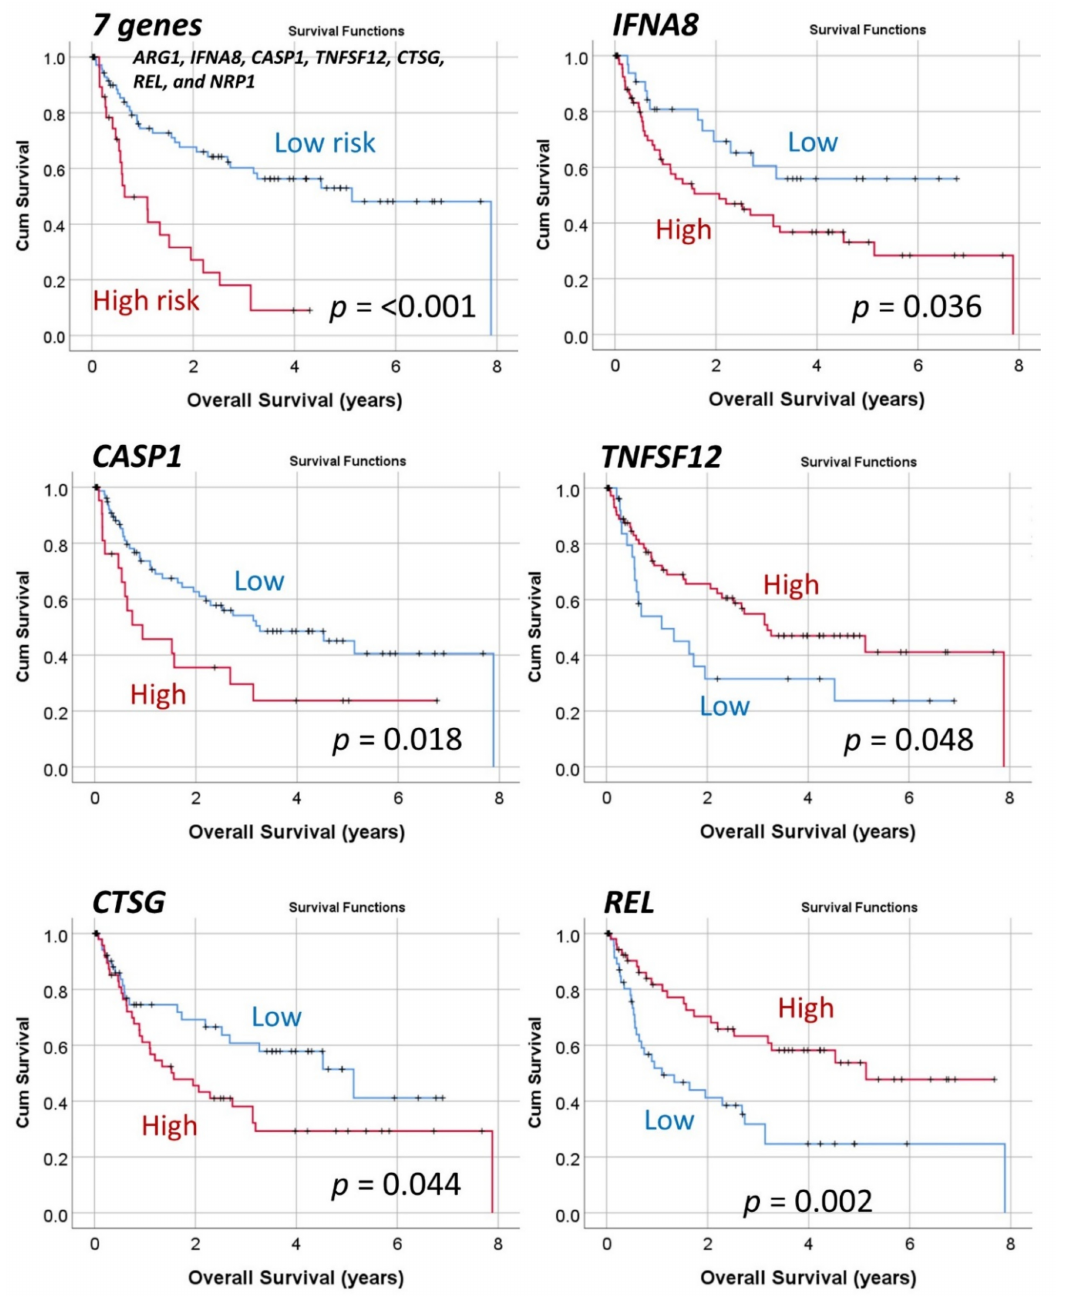
Figure 8. Overall survival according to the top genes of the MLP analysis. Because of the MLP and multivariate Cox regression analysis a final set of 7 genes were highlighted. Using a risk-score formula, the cases were divided into high and low-risk groups that had different overall survival ( p < 0.001). Additionally, using a cutoff for the gene expression values, overall survival plots were calculated for each highlighted